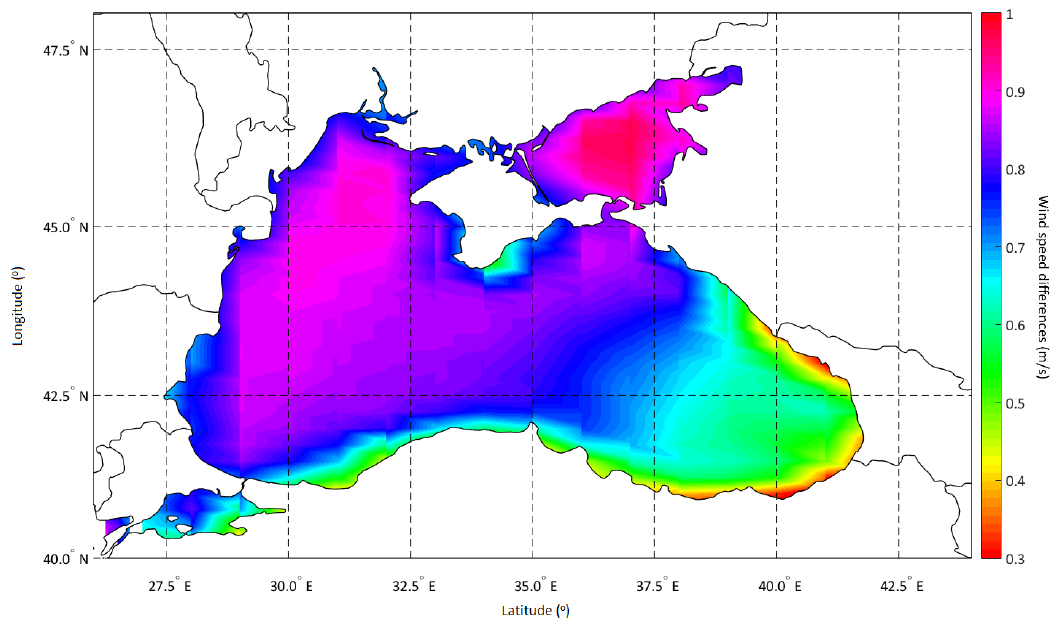
Figure 4. Direct comparison (full time distribution) between the wind conditions associated with the reference heights of 100 and 500 m (U500 minus U100 — in m/s).